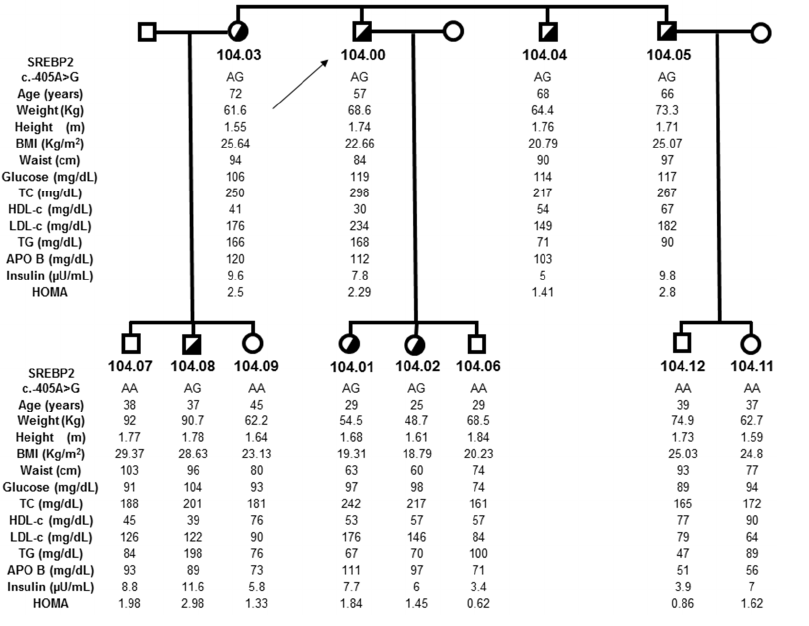
Figure 1. Pedigree structure and clinical data from family 104. Index case is identified with an arrow. ADH patients are indicated with half-filled symbols (squares: male individuals; circumferences: female individuals) (TG: triglycerides).